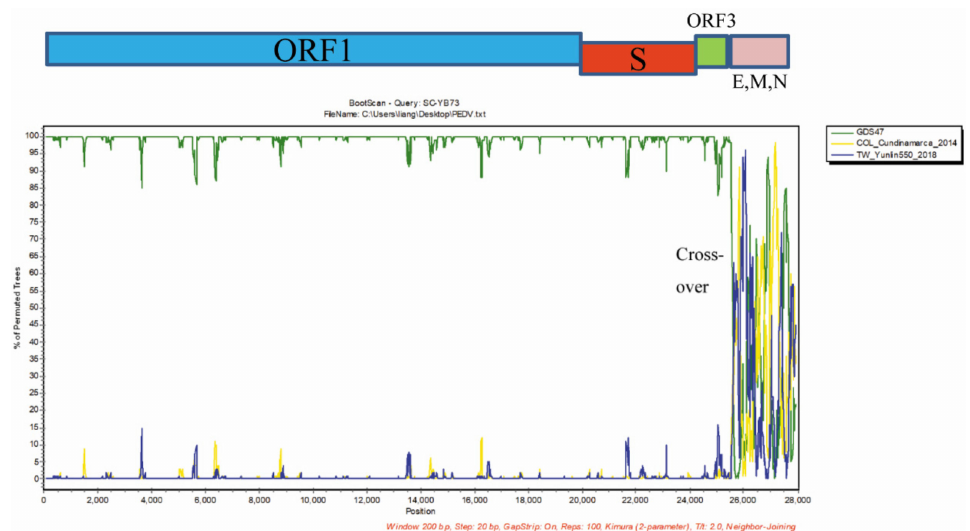
Figure 5. Recombination analysis of PEDV strains. Crossover region in SC-YB73 genome was detected with Simplot v3.5.1. Y-axis shows percentage of permuted trees employing a slid- ing window of 200 nucleotides (nt) and step size of 20 nt. Other parameters used included Kimura (2-parameter) distance model, 2.0 Ts/Tv ratio, neighbor-joining tree model, and 1000 boot- strap replicates. COL/Cundinamarca/2014:KU569509/2014/COL; GDS47:MH726382/2016/CHN;